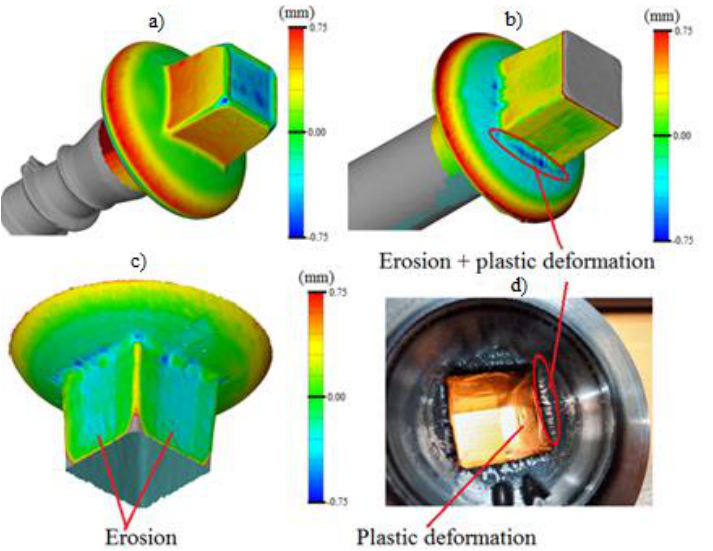
Figure 10. The 3D scan images were analyzed with GOM Inspector to determine the dimensional deviation between samples formed on new and worn dies.